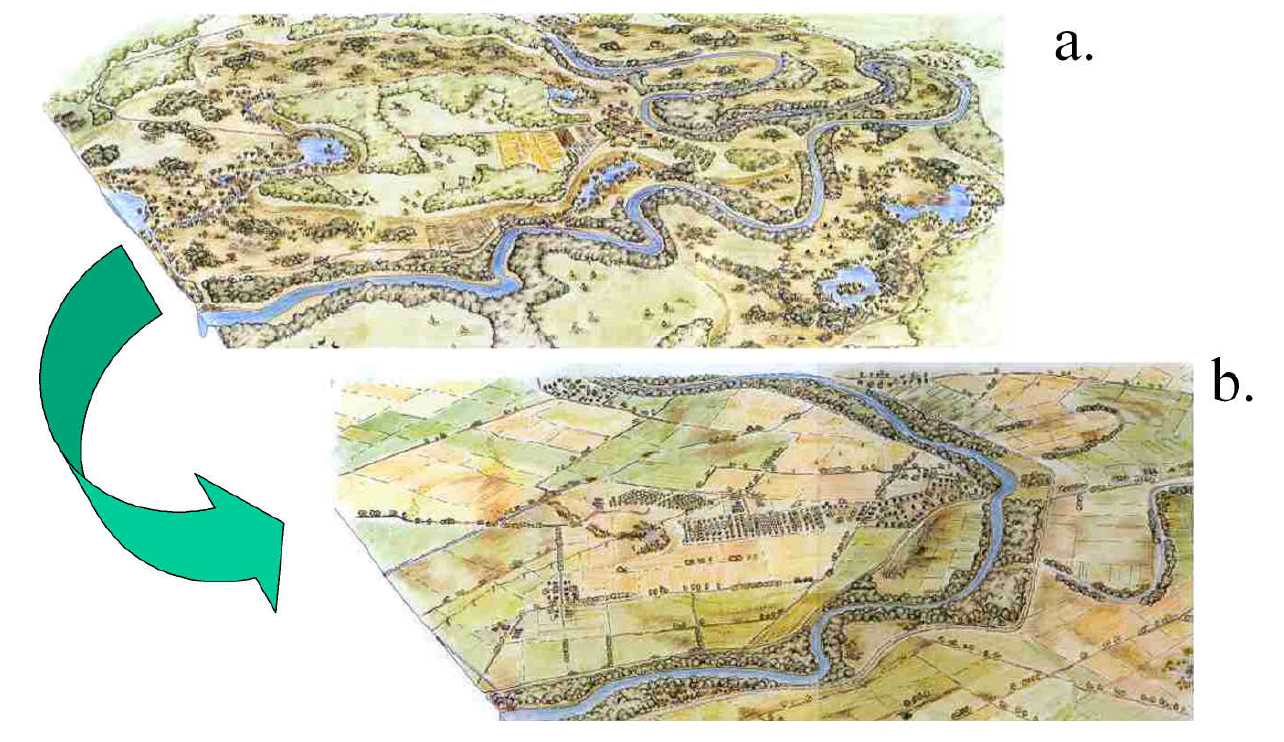
Fig. 2. Artist’s interpretation of different landscape mosaic patterns in the Tisza River floodplain both pre- (a) and post- (b) execution of the original Vasarhelyi River engineering plan in 1871. (with permission from Siposs and Kiss 2002 WWF